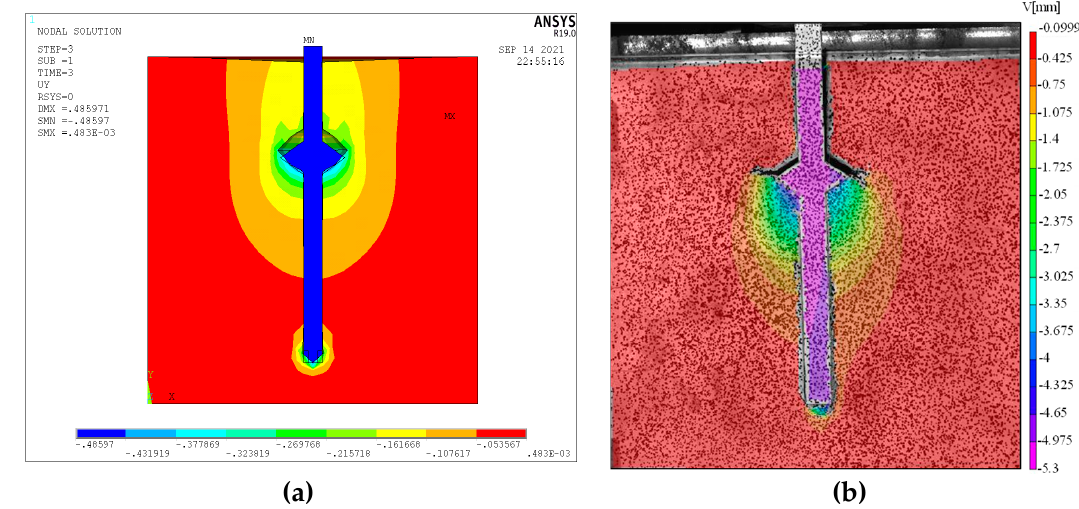
Figure 17. The vertical displacement cloud picture (0.557 kN): ( a ) numerical simulation; ( b ) model test.